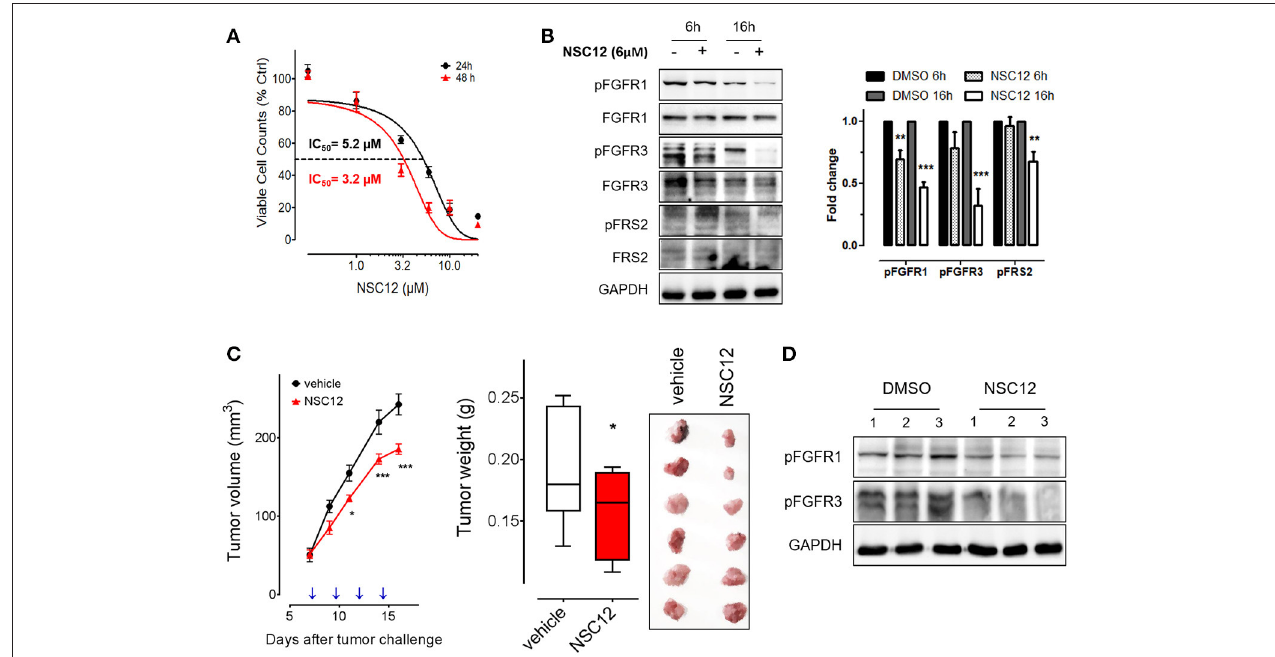
FIGURE 4 | The FGF trap small molecule SNC12 decreases cell viability, FGF/FGFR signaling and tumorigenic activity of human fibrosarcoma cells. (A) Proliferation of HT-1080 cells treated for 24 or 48h with increasing concentrations of NSC12. Data are expressed as percentage of viable cells in respect to DMSO-treated control cells. (B) Western blot and densitometric analysis of FGF/FGFR signaling in HT-1080 cells after 6 or 16h treatment with 10 µ M NSC12; Western blot analysis was performed twice; ** P < 0.01; *** P < 0.001, Student’s t -test. (C) HT-1080 cells were injected s.c in NOD/Scid mice and animals were treated with 7.5 mg/kg of